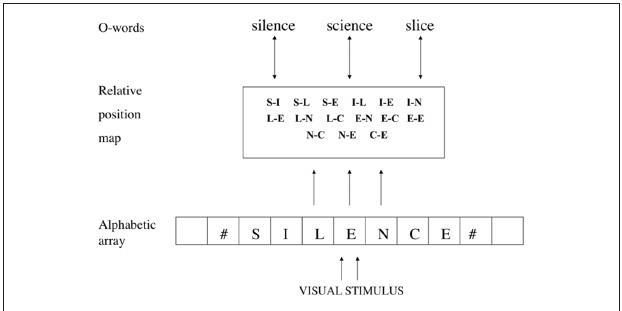
Figure 2 | grainger and van Heuven’s (2003) model of orthographic processing. Location-specific letter detectors (alphabetic array) send information to sublexical, word-centered, orthographic representations (relative position map), which in turn activate whole-word orthographic representations